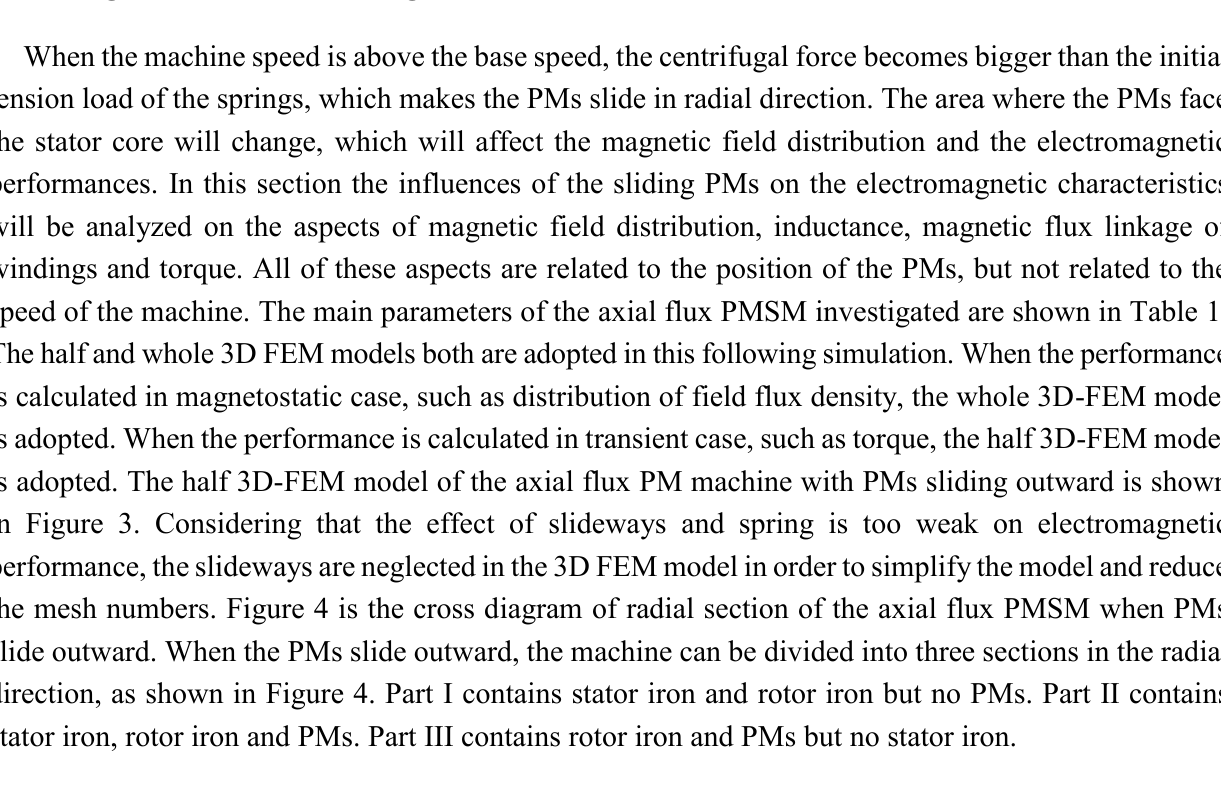
Table 1. Main initial parameters of axial flux PMSM with radially sliding permanent magnets